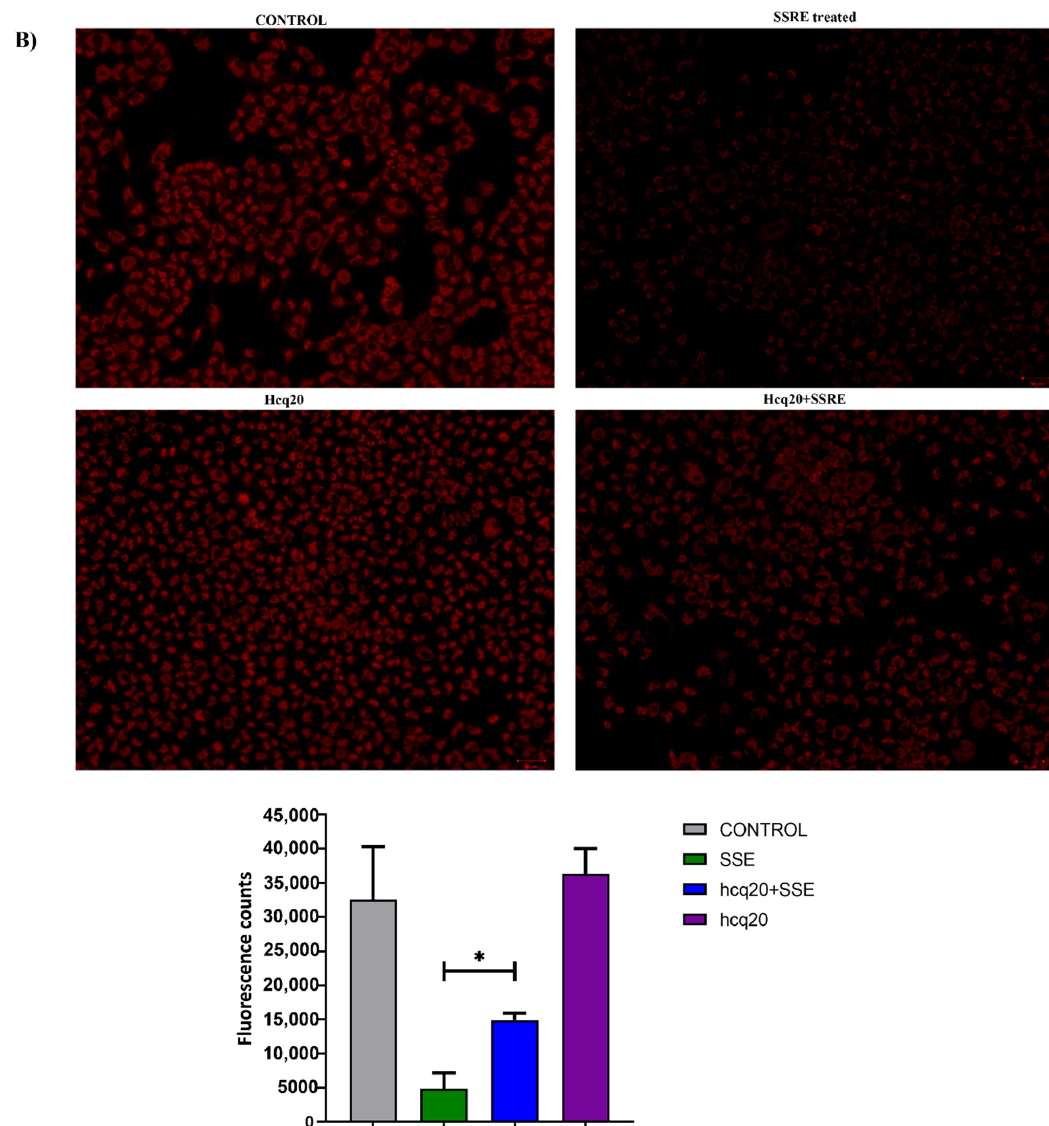
Figure 6. Compensatory activity of SSRE through oxidative-phosphorylation pathway. ( A ) Mito- chondrial membrane potential assay . A549 cells were treated with 200 µg/mL extract for 6 h and stained with JC-1. Changes in mitochondrial membrane potential were detected using a JC-1 assay kit containing the cationic dye, which undergoes a readily detectable shift from red to green with decreases in membrane potential. The left panel of the bar graph (red—number of healthy mito- chondria) describes a degradation of mitochondria after treatment with the extract. On the right panel (green—the number of unhealthy mitochondria), the level of damaging of the membrane potential of mitochondria after administration of extract was shown. Microscopy images demonstrate the number of mitochondria inside the cells in red, unhealthy mitochondria shown as green in A549 cells before and after exposure to SSE extract. FCCP (mitochondrial oxidative phosphorylation uncoupler) was used as a positive control which damages mitochondrial membrane potential. ( B ) Mitochondrial autophagic degradation assay. Representative immunofluorescence images using a confocal micro- scope. A549 were treated with 200 µ g/mL extract and/or with autophagy inhibitor hcq (blocker of the lysosomal H + -ATPases hydroxychloroquine) with or without SSE administration for 6 h and stained with JC-1. The intensity of fluorescent dye represents the amount of mitochondrial content inside the cells. The bar graph indicates the statistical difference in the mitochondrial content of A549 cells. Imaging results are representative of three biological replicates ( n = 3). ***, p < 0.005, *, p <